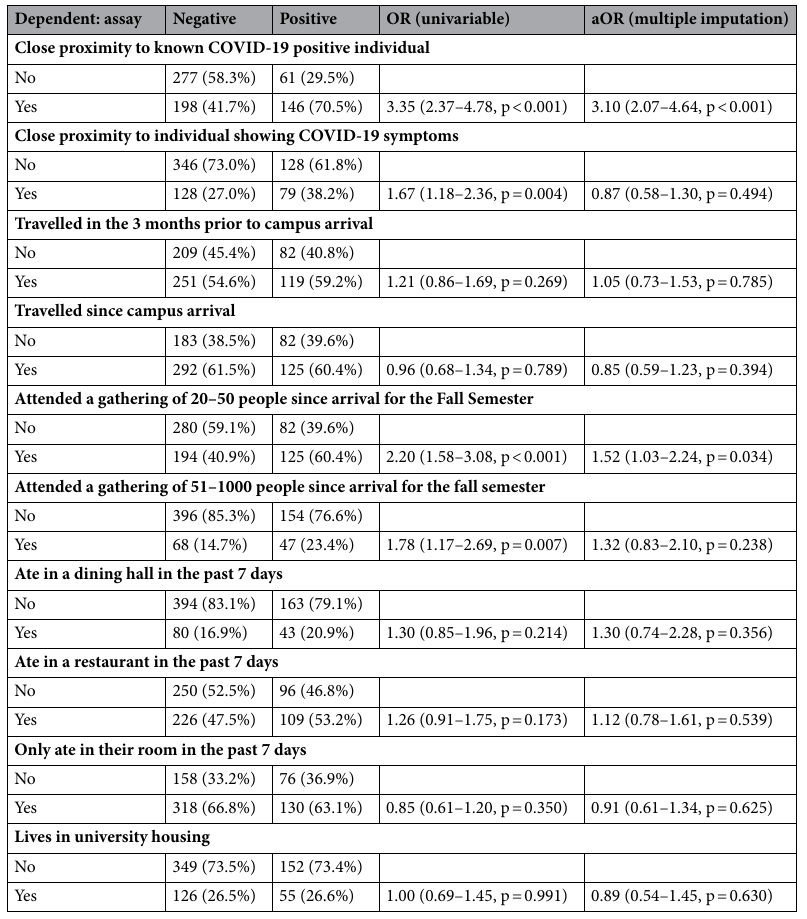
Table 4. Crude and adjusted odds ratios (OR; aOR) of risk factors among returning PSU UP student